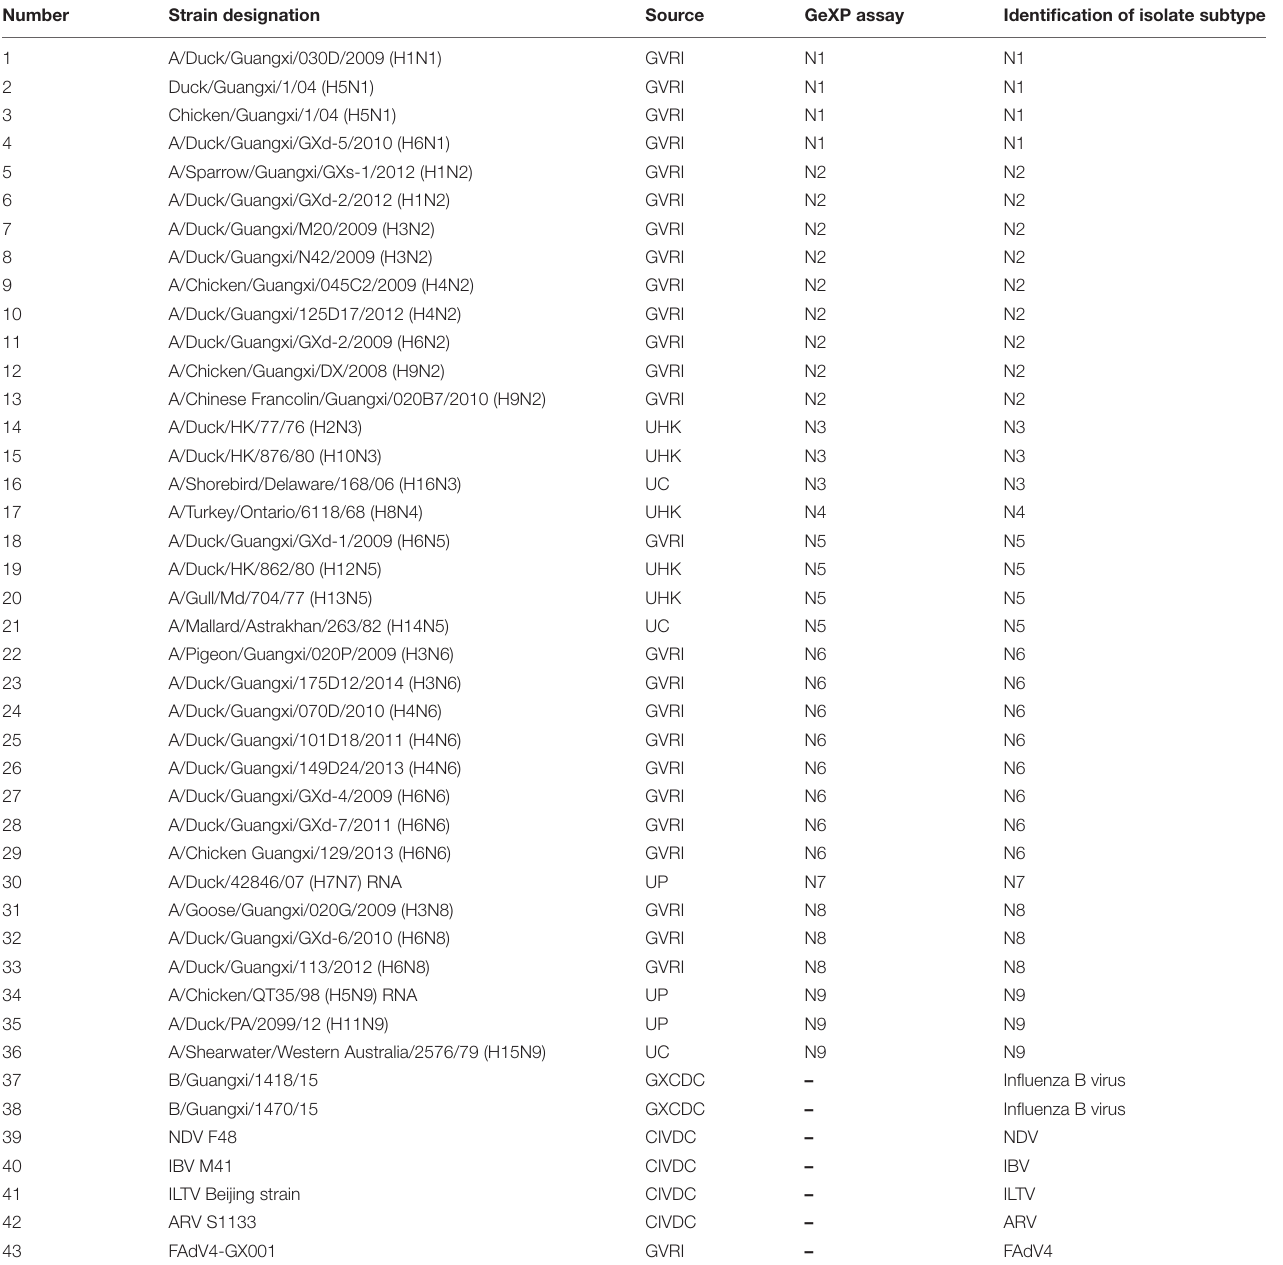
TABLE 2 | Reference strains used in the GeXP